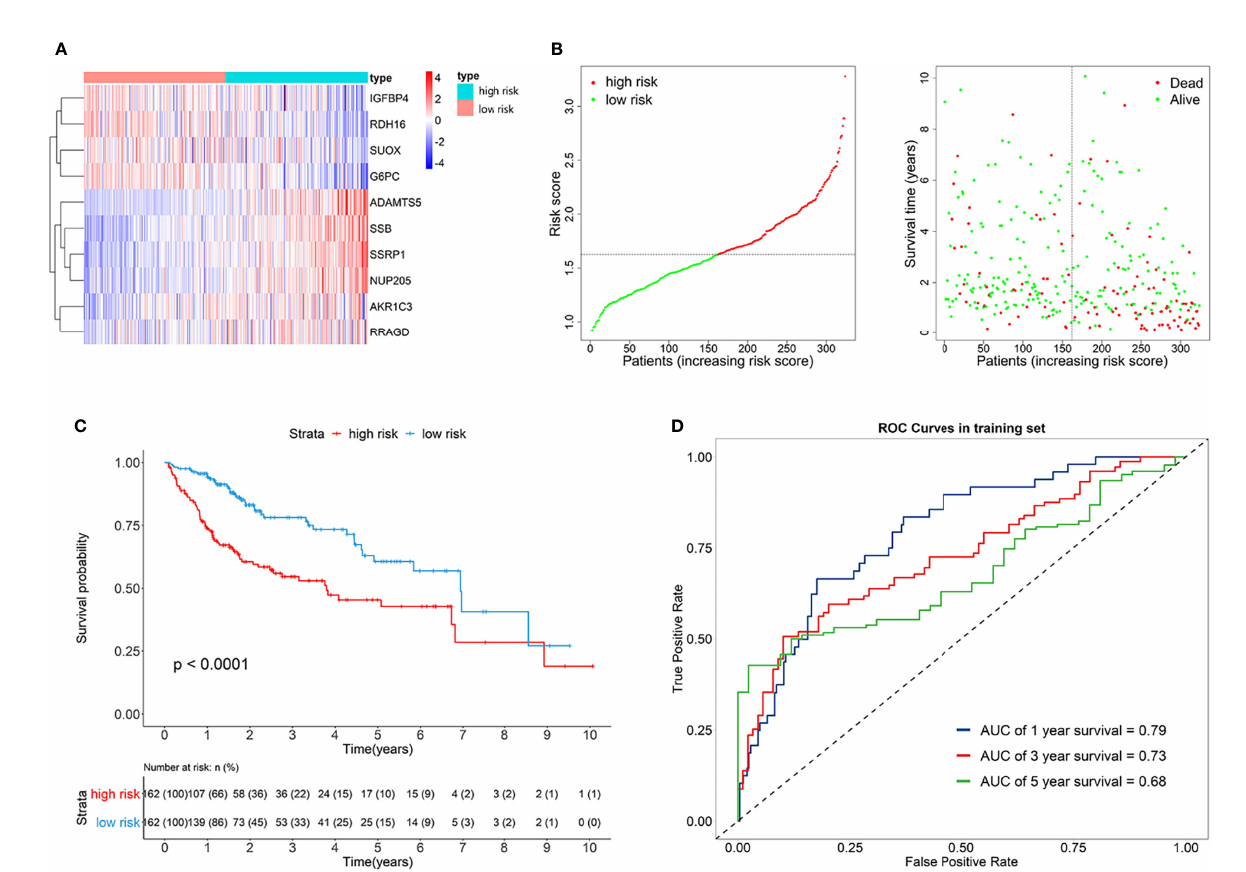
FIGURE 3 | (A) Heatmap of the signature genes expression pro fi les in training set, and the colors represent centered and scaled log2FPKM value in the row direction (FPKM is de fi ned as fragments per kilobase of transcript per million mapped reads); (B) Survival status distribution of patients in high risk and low risk group; (C) Kaplan-Meier curves of the signature for high risk and low risk group in training set; (D) Time-dependent ROC curves of the signature for 1-, 3-, 5-year overall survival in training